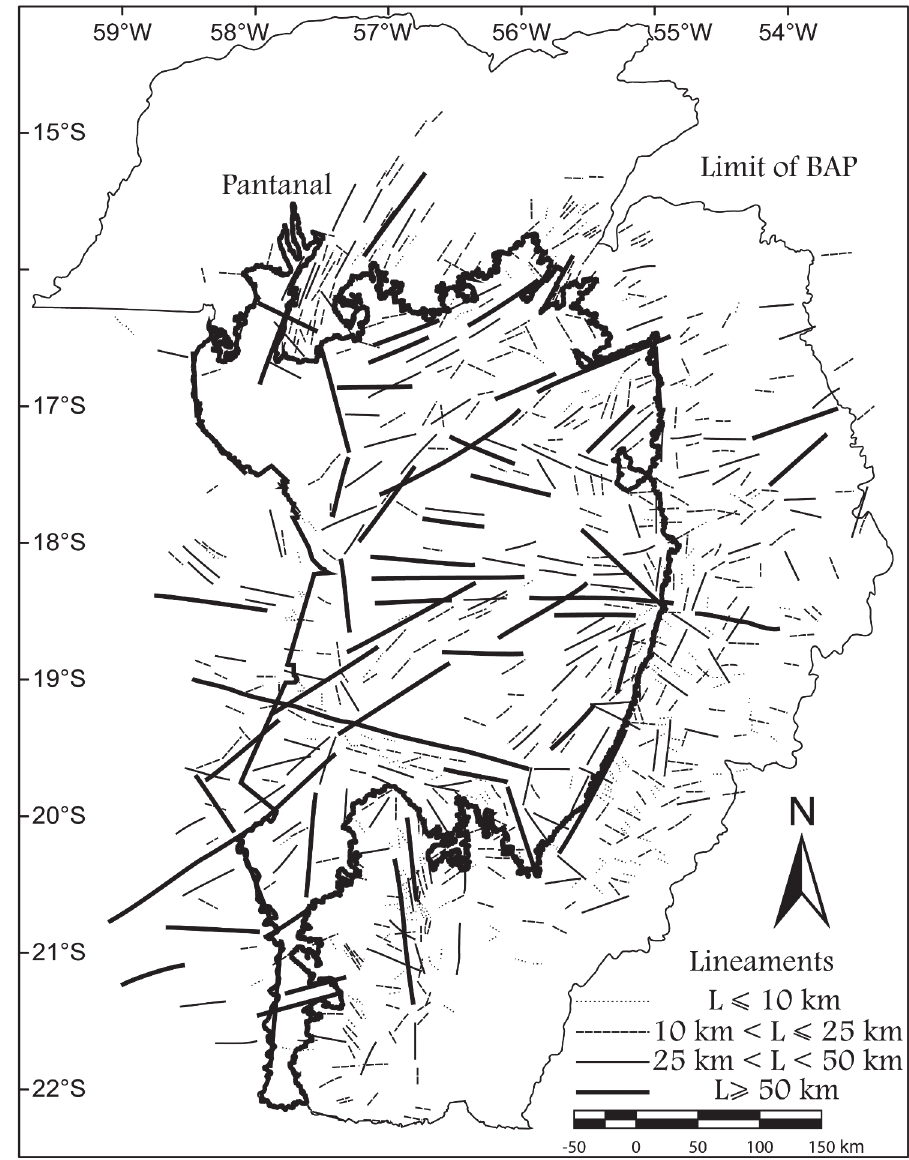
Figure 3 - The lineaments obtained through photointerpretation of satellite images. The main systems are NNE/SSW, EW, NE/SW and NW/SE (the last two being associated